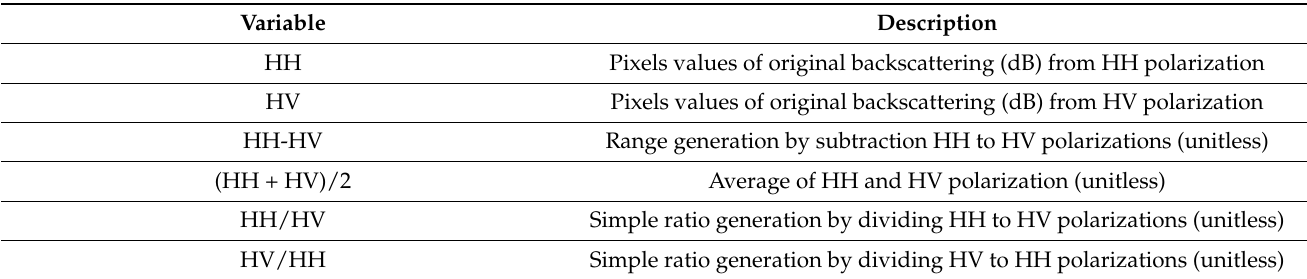
Table 4. In this study, the variables of backscatter of dual-polarization values were used as the ML inputs as illustrated in Table 5. Table 4. Variables used to classify trees that were non-infected and infected by G. boninense (Adapted from [59]).